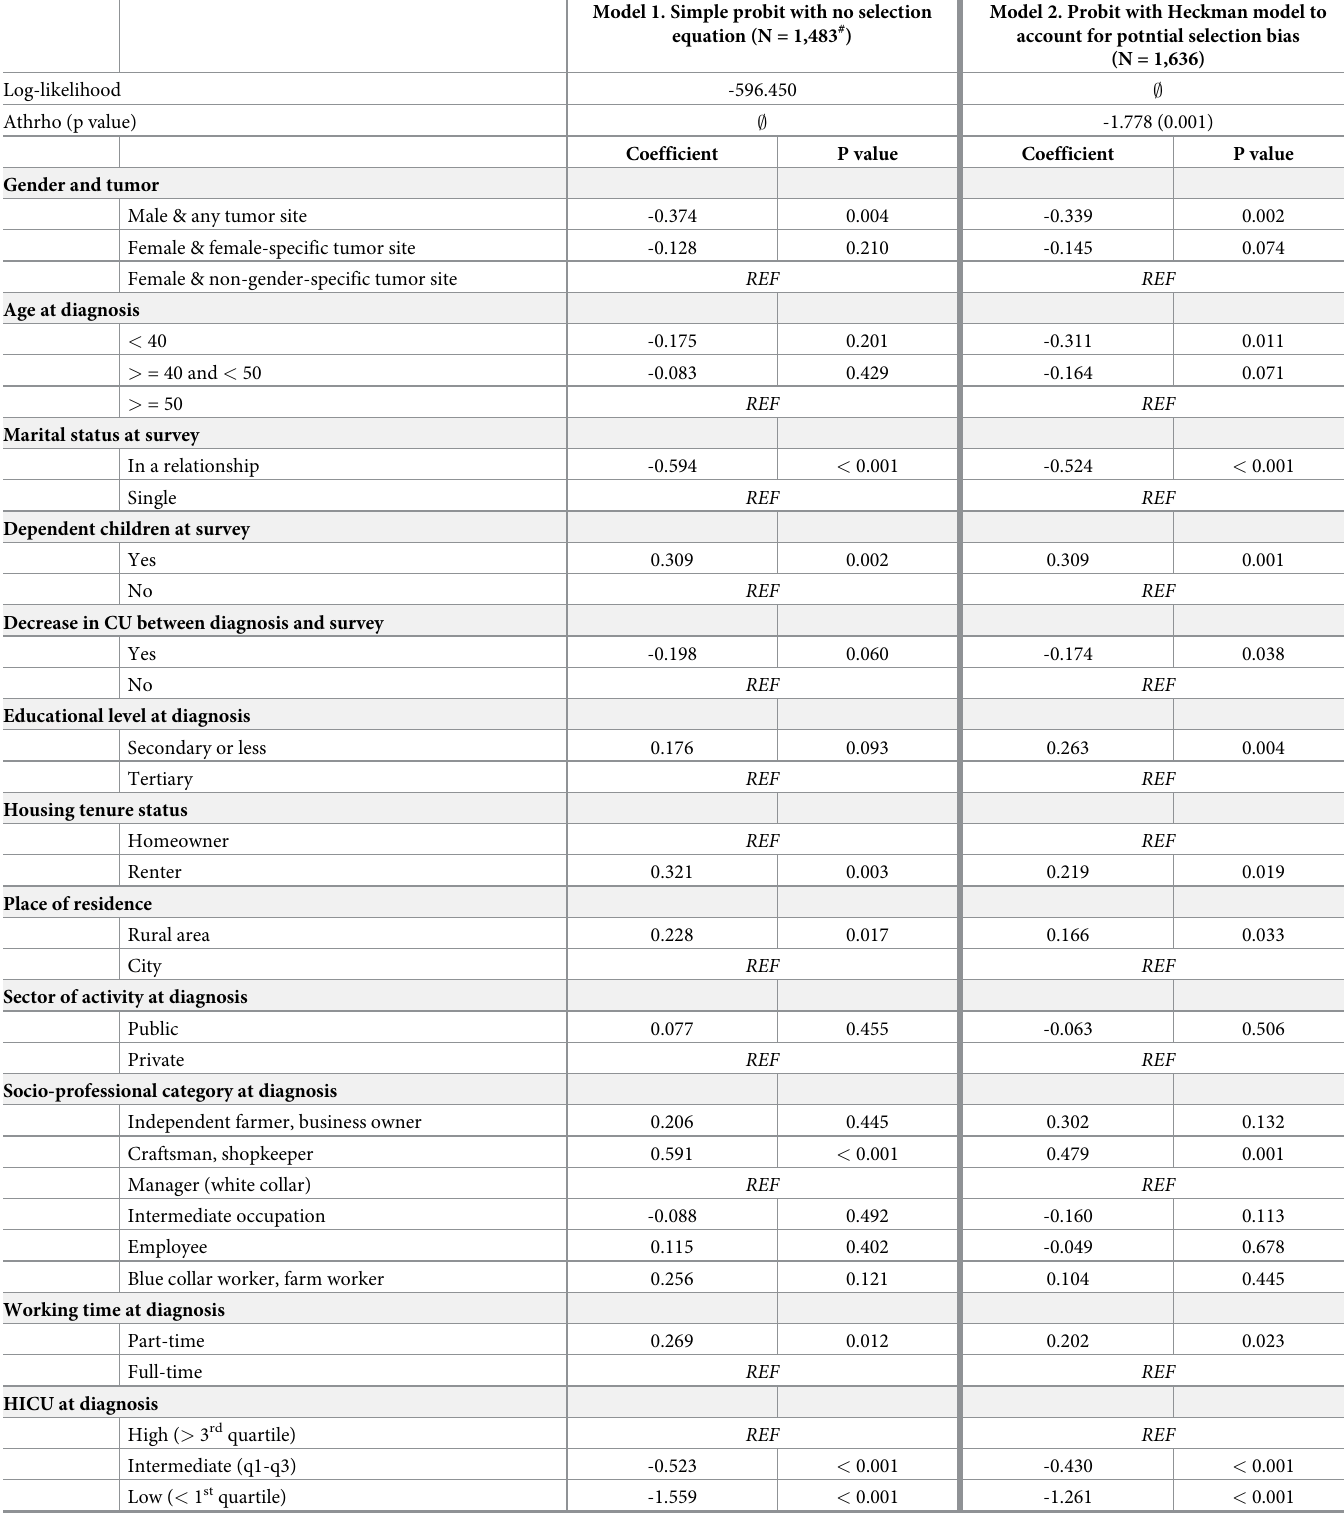
Table 3. Factors associated with a decrease in HICU.